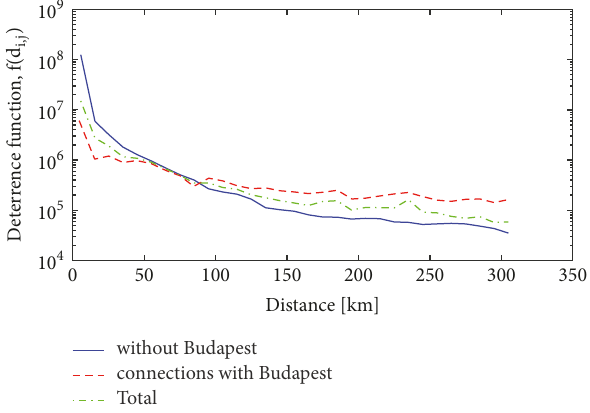
Figure 5: Empirically derived deterrence function determined by (19), where 𝐼 [𝑖𝑛] 𝑖